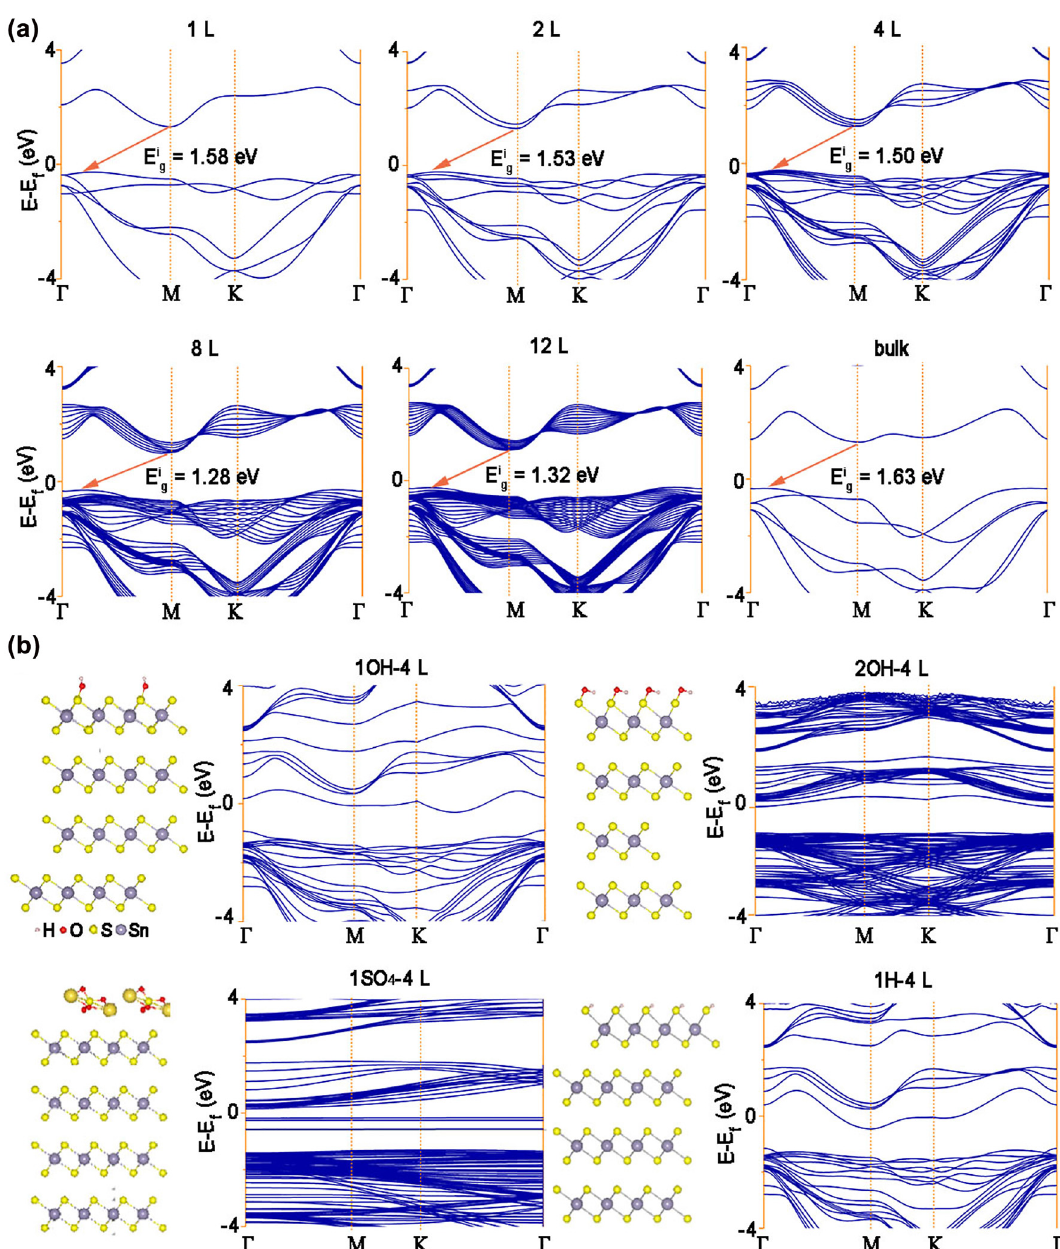
with different layers. (a) Calculated band structures of SnS 2 coordinated with 1OH, 2OH, 1SO 2